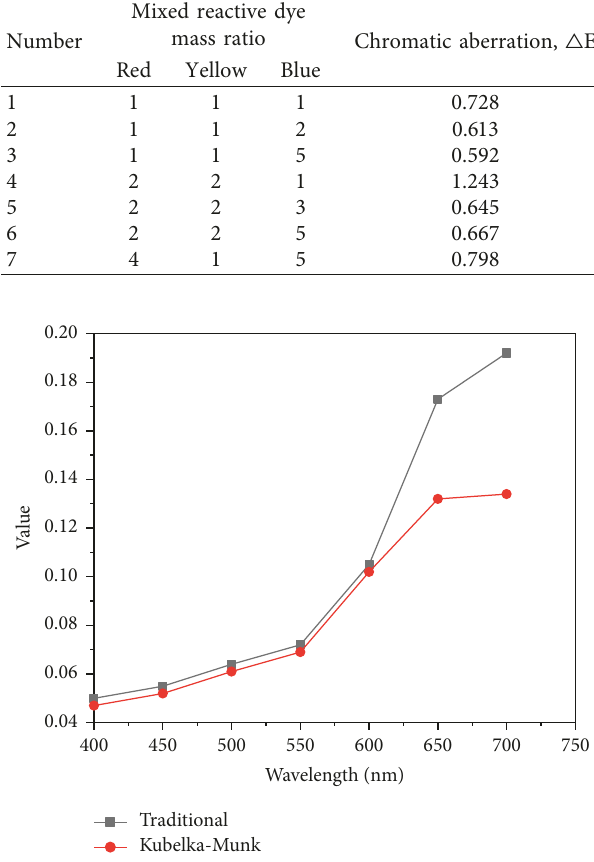
Figure 2: Fitting formula color error comparison chart (red silk).